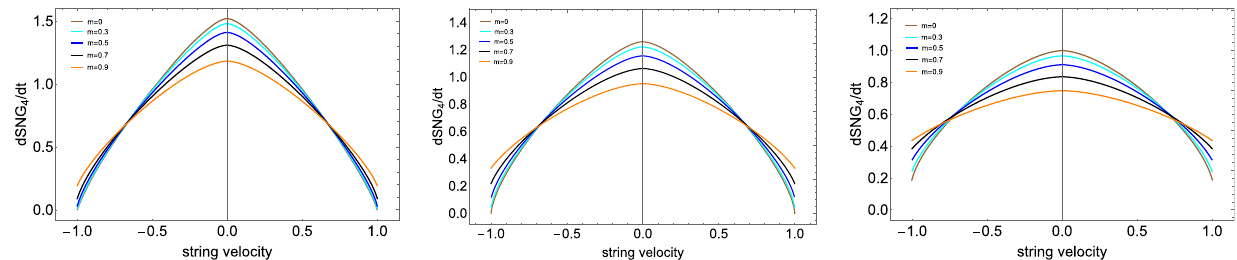
Fig. 7 Action growth v.s. string velocity for massive AdS 4 black hole with m 0 = 2. From left to right, the horizon curvature is k = − 1, k = 0 and k = 1, respectively